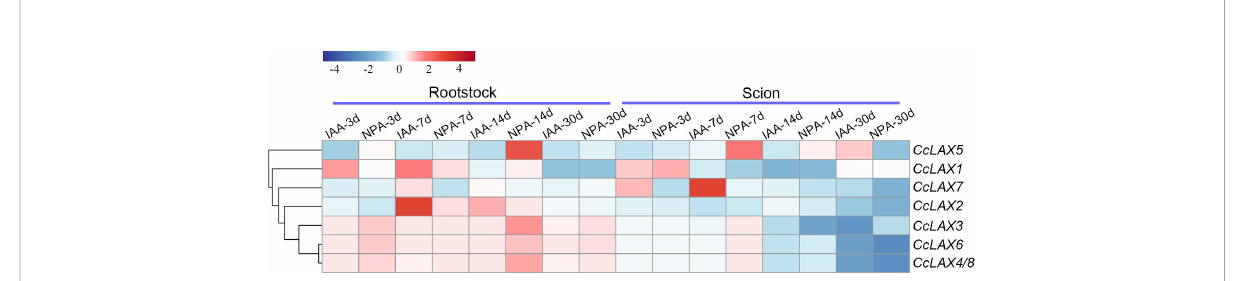
FIGURE 8 Expression patterns of CcAUX/LAX genes in response to IAA and NPA during grafting. Red and blue represent relatively high and low expression compared to the control, respectively. The values used in the heat map were the mean of four replicates, and normalized to the control sample. The control samples were scion and rootstock collected at day 0 of